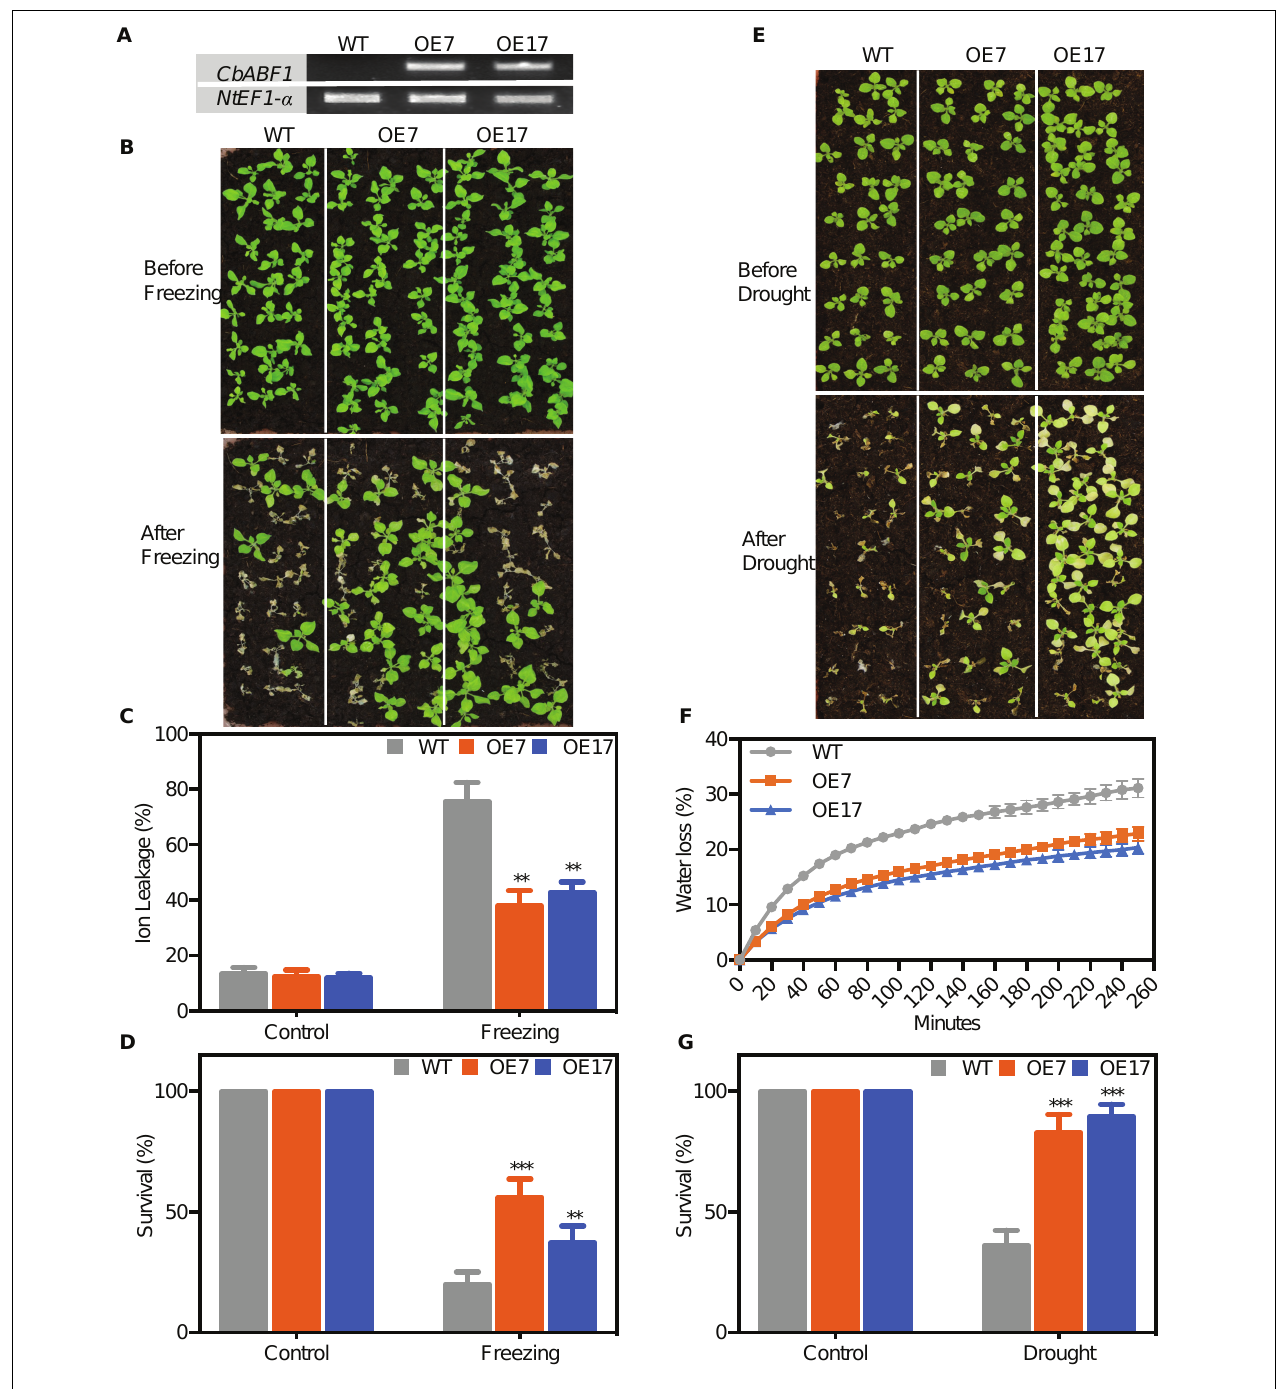
FIGURE 6 | Analysis of freezing and drought tolerance in 35S:CbABF1 transgenic plants. (A) Expression analysis of the CbABF1 gene in transgenic tobacco lines. The wild type (WT) and transgenic lines (OE7 and OE17) were cultured on MS medium for 2 weeks and whole seedlings were used to extract RNA to detect gene expression using NtEF1- α as an internal control. (B) Four-week-old wild type (WT) and transgenic tobacco lines OE7 and OE17 ( 35S:CbABF1 ) were subjected to freezing for 11 h at –4 ◦ C. After incubation at 4 ◦ C for 1 day, plants were returned to 25 ◦ C. Survival rates were determined, and photographs were taken 5 days later. (C,D) Ion leakage and survival rates of WT and transgenic lines after freezing treatment in panel (B) . (E) Four-week-old wild type (WT) and transgenic tobacco lines OE7 and OE17 ( 35S:CbABF1 ) were drought stressed by withholding water for 12 days, and then re-watered for 5 days before photographs were taken. (F) Water loss from the leaves of wild type (WT) and transgenic tobacco lines OE7 and OE17 at various time points after detachment of leaves. (G) Survival rates of WT and transgenic lines after drought treatment in panel (E) . Error bars represent SD [ n = 18 in panels (C,F) ; n = 72 in panels (D,G) ]. Two-way ANOVA (Tukey test) was performed, and statistically significant differences are indicated by asterisks ( ∗∗ P < 0.01 and ∗∗∗ P < 0.001). Values shown are derived from experiments that were performed at least three times with similar results, and representative data from one repetition are presented.